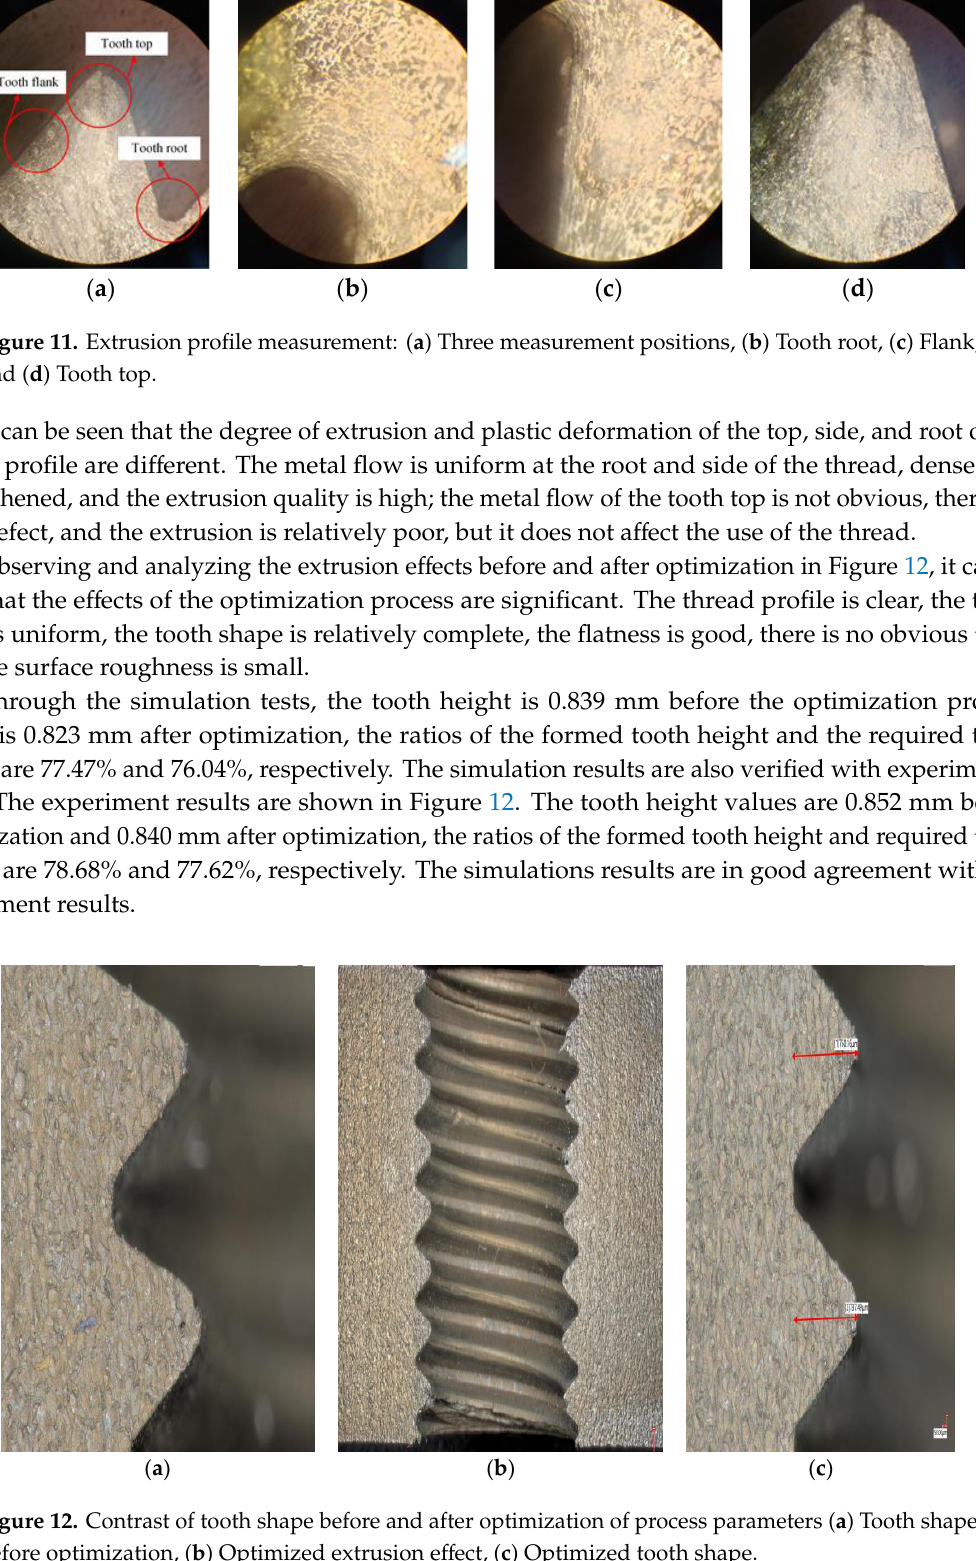
Figure 12. Contrast of tooth shape before and after optimization of process parameters ( a ) Tooth shape before optimization, ( b ) Optimized extrusion effect, ( c ) Optimized tooth shape.